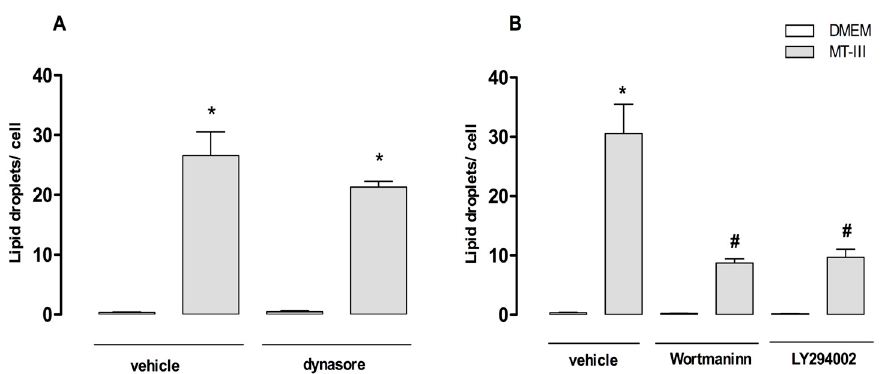
Figure 9. E ff ect of inhibitors of macropinocytosis and receptor-mediated endocytosis in MT-III-induced LD formation in VSMCs. VSMCs (8 × 10 3 cells / coverslip) were incubated with one of the following inhibitors before stimulation with MT-III (0.4 µ M) for 12 h: ( A ) dynasore (100 µ M) for 1 h or ( B ) LY294002 (100 µ M) or wortmaninn (2 µ M) for 1 h. LDs were counted using light microscopy after osmium staining. Each bar represents the mean ± SEM of the number of LDs / cell in 50 cells. Values represent means ± SEM for three independent experiments ( n = 9) (ANOVA). Note: * p < 0.05 compared with vehicle treated cells; # p < 0.05 compared with vehicle treated cells incubated with MT-III.